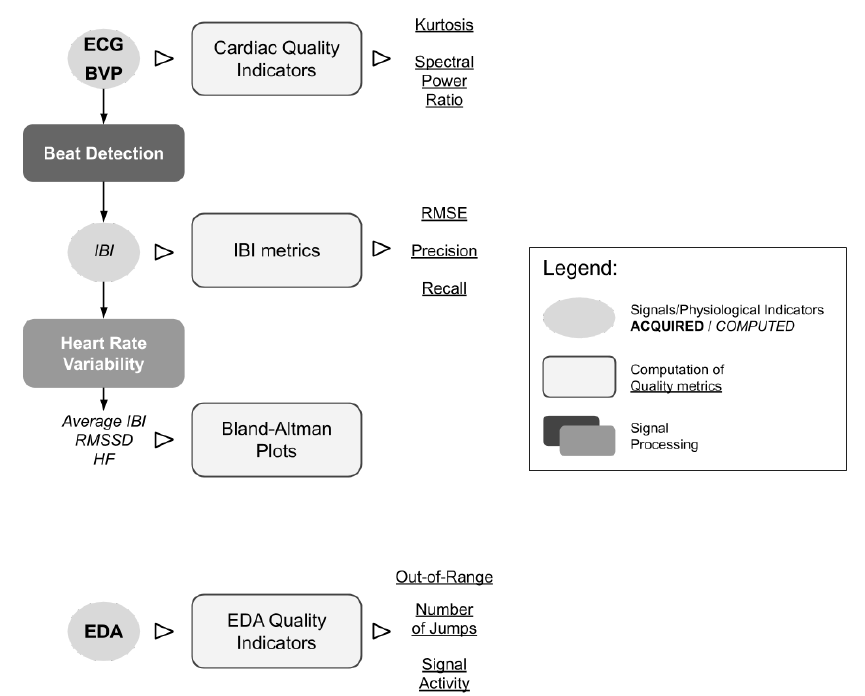
Figure 3. Data analysis procedure adopted in this study. IBI: inter-beat intervals; RMSSD: root of the mean of the squares of subsequent differences; HF: high